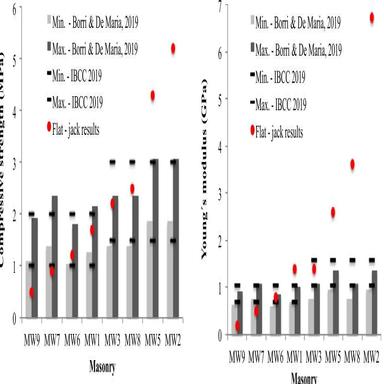
Estimated compressive strength (left) and Young's modulus (right) for tested masonry walls by IBCC 2019 and Borri & De Maria, 2019, and the results obtained using in- situ flat-jack testing.